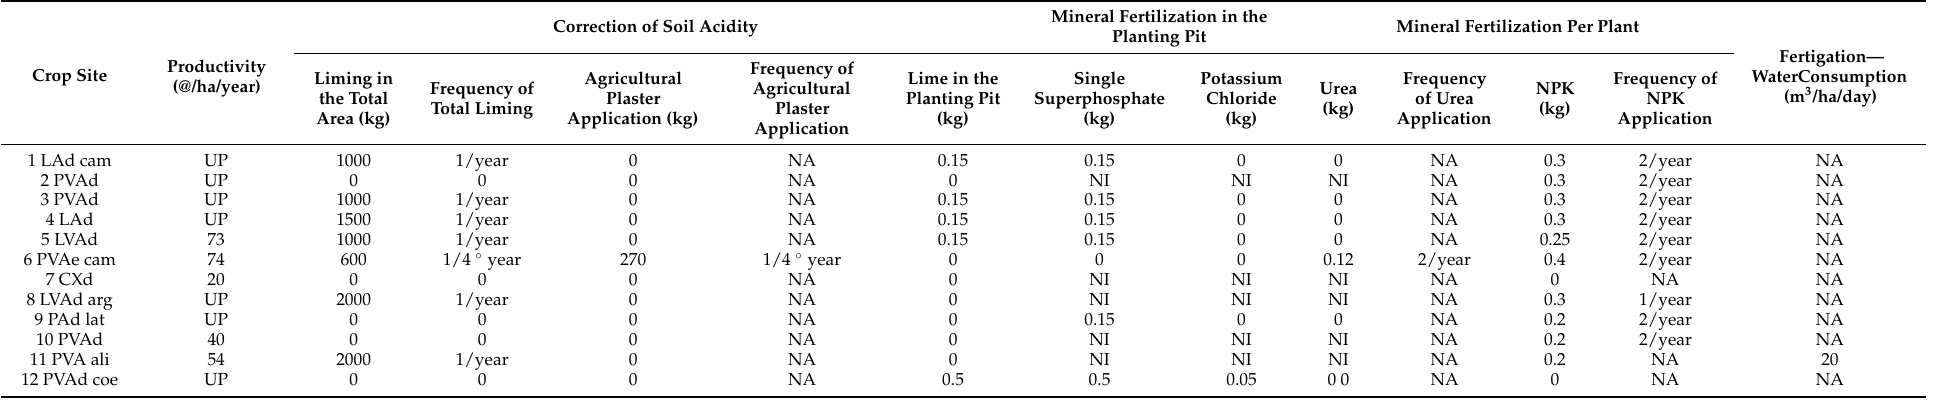
Table 2. Soil management of the 12 crop sites for the PH-16 cacao clone in the humid region of southeast Bahia: correction of soil acidity, mineral fertilization and irrigation.